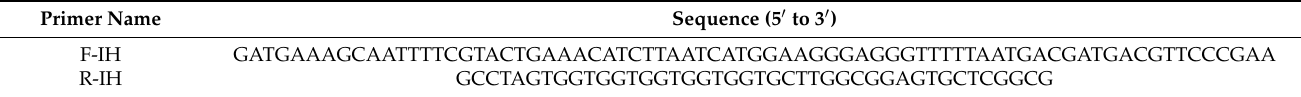
Table 4. Primers used in this